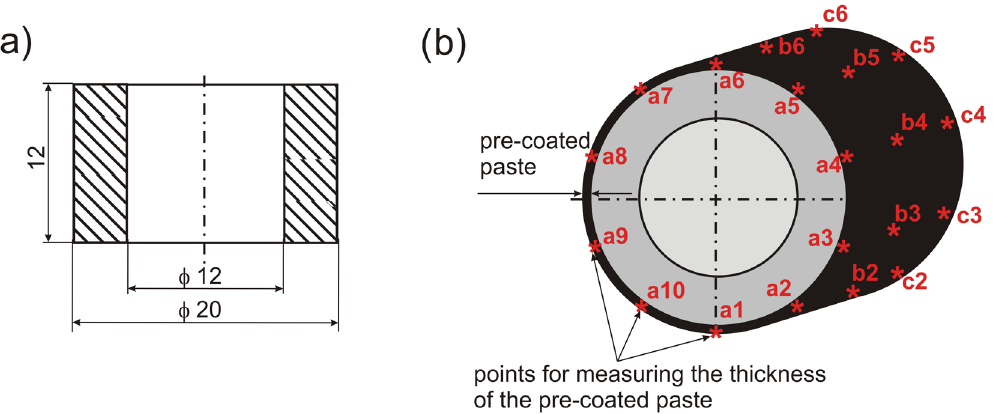
Figure 2. The shape and dimensions of the specimens used for laser boriding ( a ) and the scheme of the specimen with marked points for measuring the thickness of the pre-coated paste ( b ). Table 1. The results of the measurements of the thickness of the pre-coated paste with amorphous boron applied to the samples intended for laser boriding using a laser beam power of 1.3 kW, 1.56 kW, and 1.95 kW.